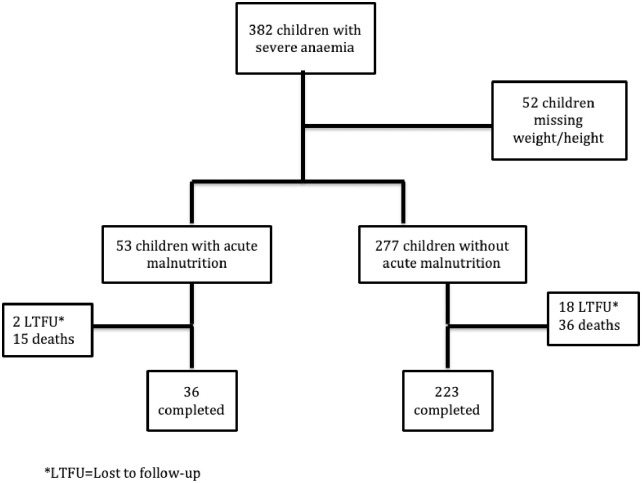
Study flowchart.